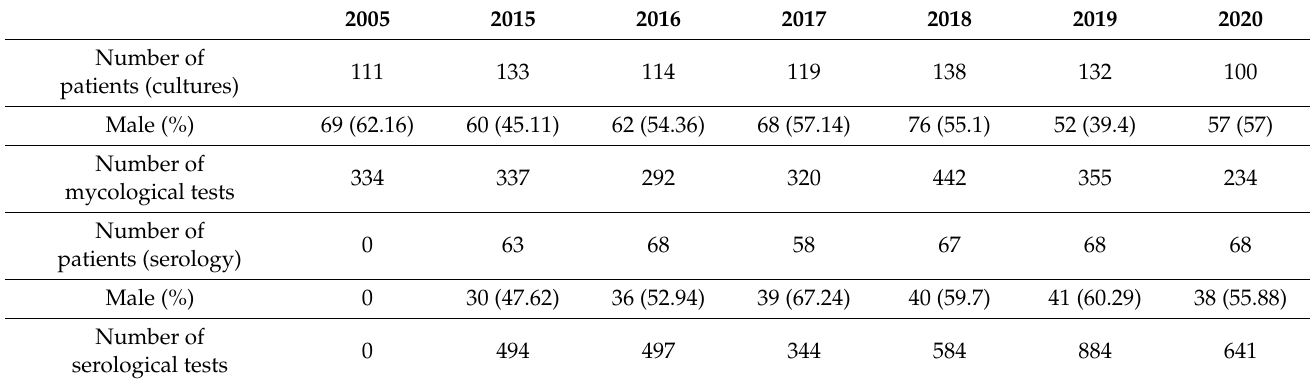
Table 1. Patient and test numbers in the studied